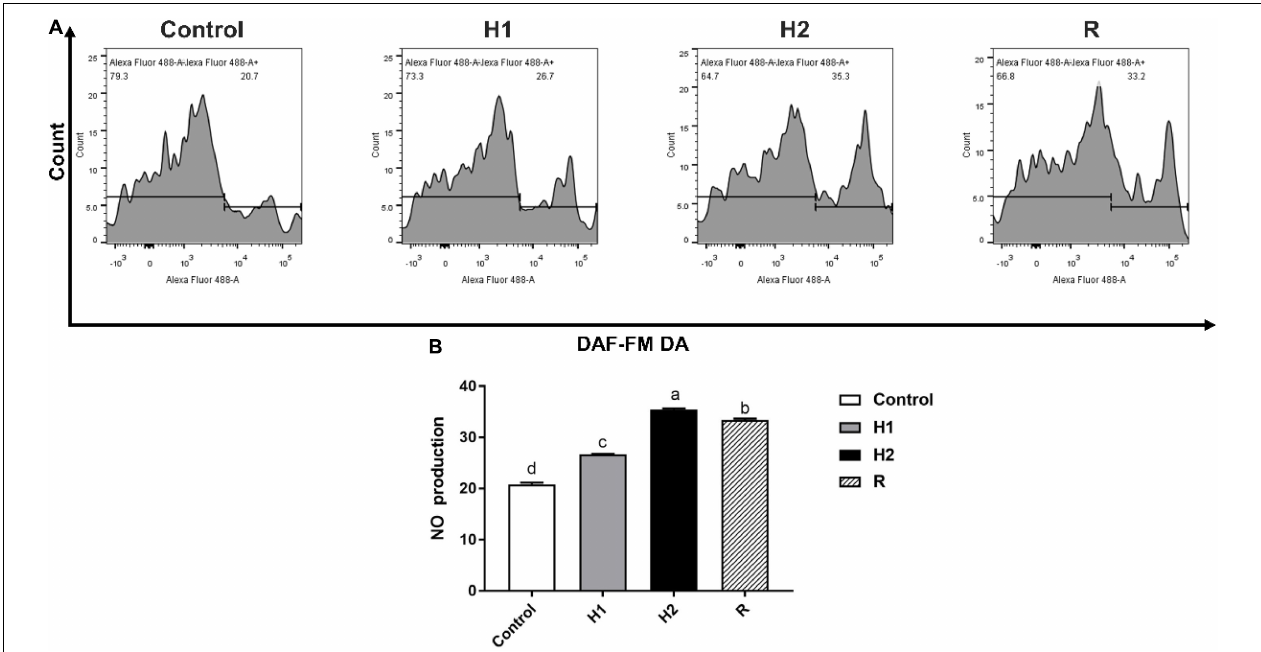
FIGURE 4 | The difference of NO production in the blood cell of largemouth bass under acute hypoxia and reoxygenation. (A) The NO production of blood cell was determined by flow cytometry. (B) The NO production for each cell treatment. Data are expressed as the mean ± SD ( n = 3; one-way analysis of variance followed by the T -test). All experiments were conducted in triplicate. Different lowercase letters above each bar represent significant differences ( P < 0.05).